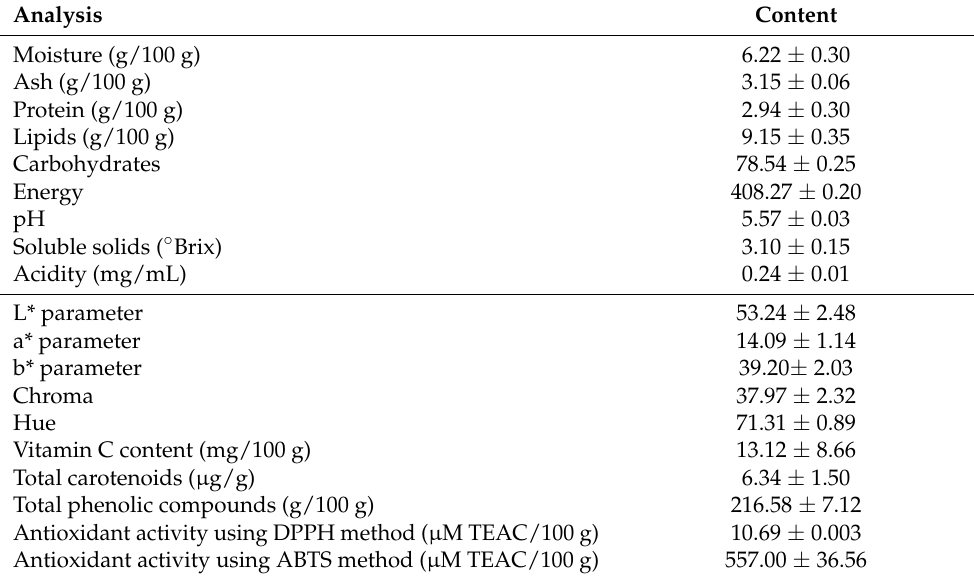
Table 2. Proximate composition and properties of Acromia aculeata (Jacq.) Lodd.